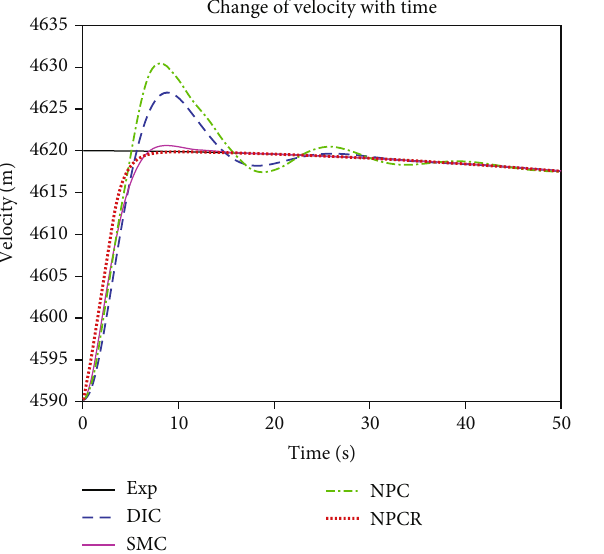
Figure 3: Velocity changes with time under di ff erent